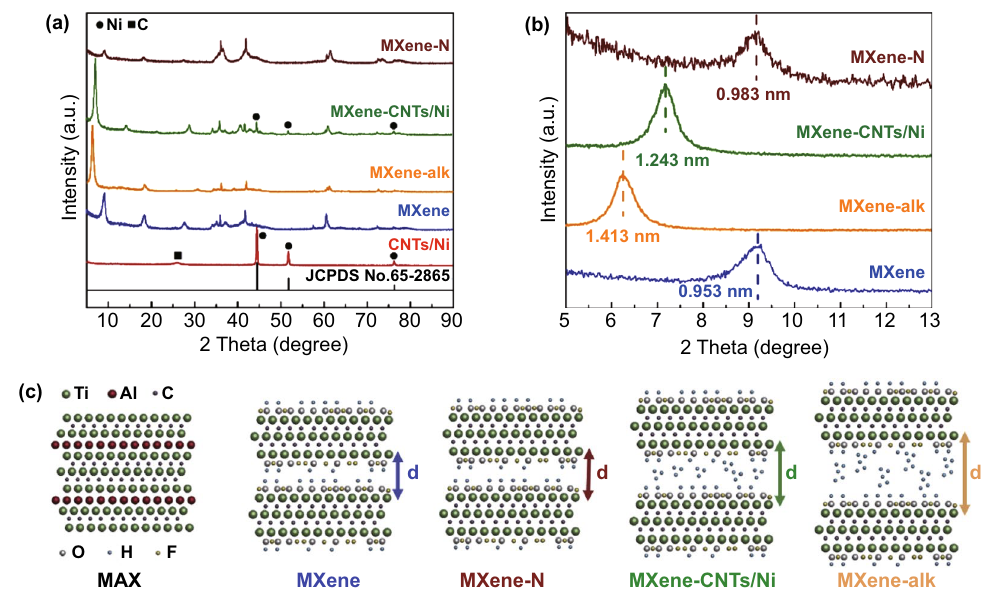
Fig. 1 a XRD patterns of four different samples (MXene, MXene-alk, MXene-N, and MXene-CNTs/Ni). b Magnification of XRD patterns in a.